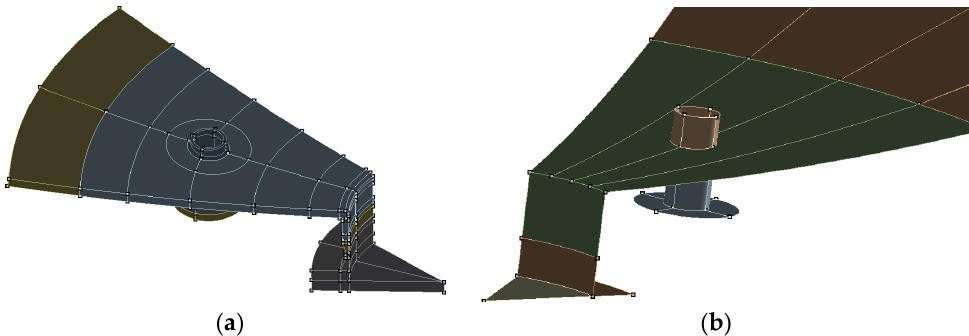
Figure 3. Geometrical model of part of the pressure vessel in area of stub and manhole modeled with solid modeling approach ( a ) and shell modeling approach ( b ).